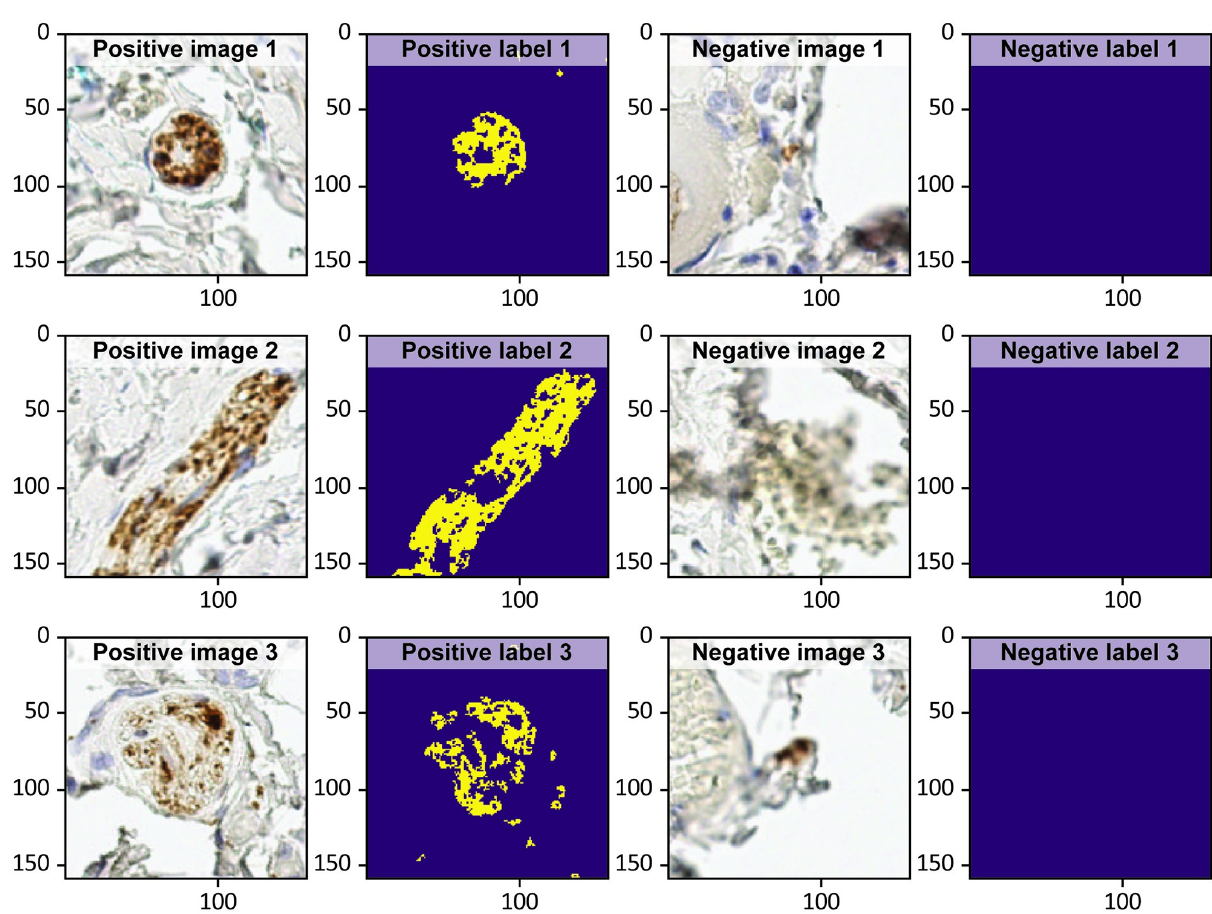
Fig 12. Examples of the positive and negative training data